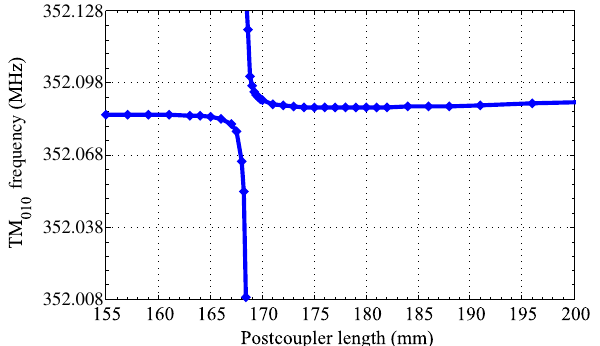
FIG. 8. Variation of the tilt sensitivity with individual adjust- ment of tuners 1, 13, and 17. The influence by individual tuners is small, while there is a clear dependency on the resonance frequency of the structure when adjusting all tuners uniformly to an offset of (cid:2) 0 . 02 MHz.